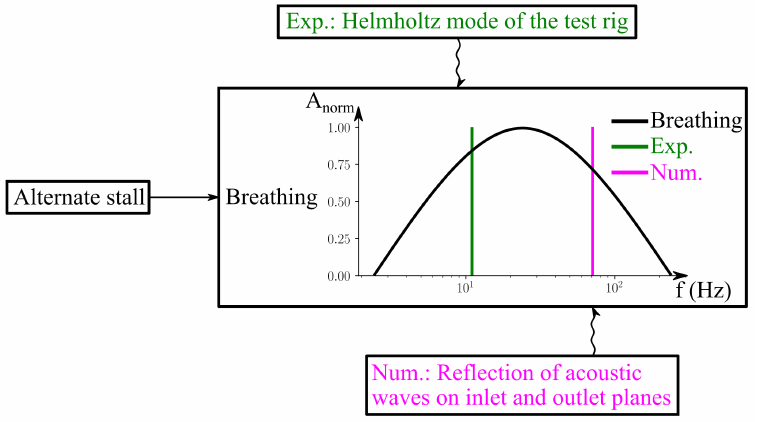
Figure 18. Resonator difference for alternate stall pulsation between experiments and numerical